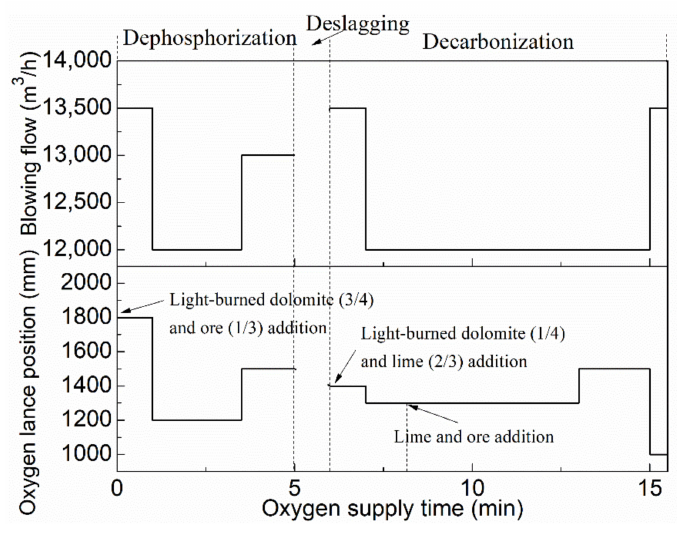
Figure 2. Control scheme of IDDSC